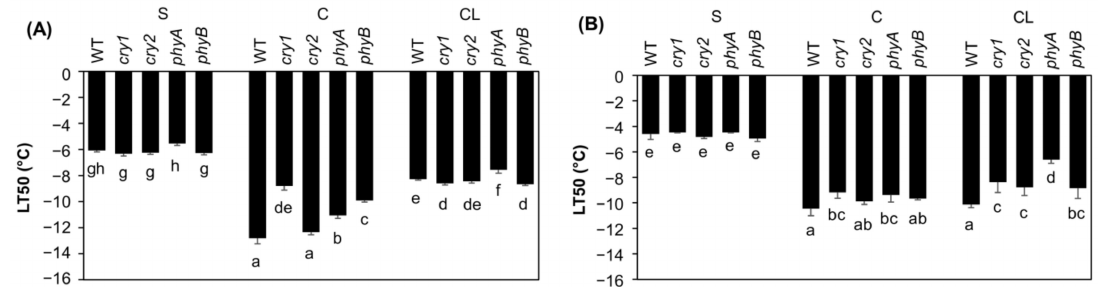
Figure 1. Freezing tolerance of ( A ) leaves and ( B ) whole plants expressed as LT50 values. Plants were pretreated by standard (S), cold (C) or combined cold and low light (CL) conditions for one week. Means ± SD are shown in plots. Between-treatment and between-genotype differences were evaluated by one-way ANOVA with Tukey’s test ( p < 0.05, n = 6).